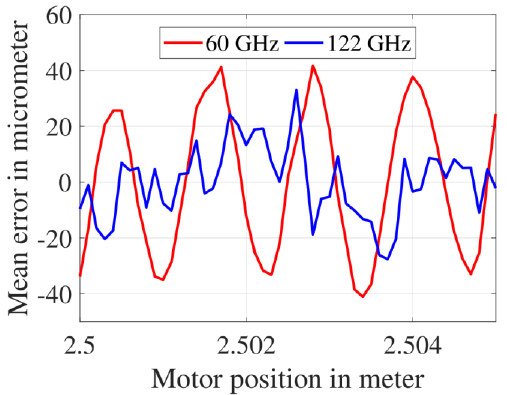
Figure 9. Mean distance measurement error after the second CZT iteration.